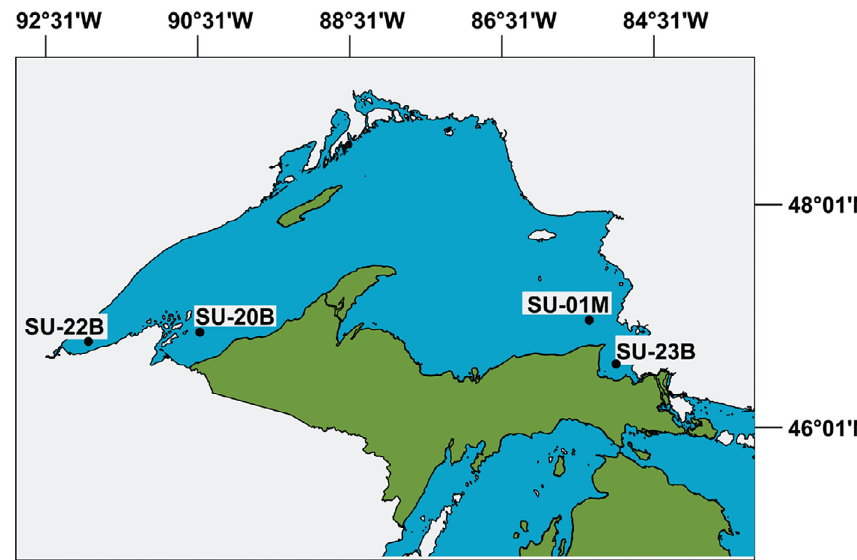
Figure 1. Sampling sites in Lake Superior where Diporeia sp. (Amphipoda, Gammaridae) were